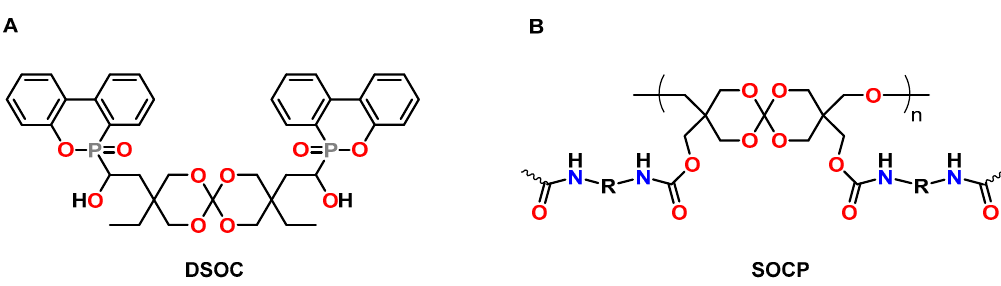
Figure 16. A : Chemical structures of the phosphorous-containing SOC DSOC. B : Chemical structure of the SOC-based Figure 16. ( A ): Chemical structures of the phosphorous-containing SOC DSOC. ( B ): Chemical structure of the SOC-based prepolymer SOCP. prepolymer